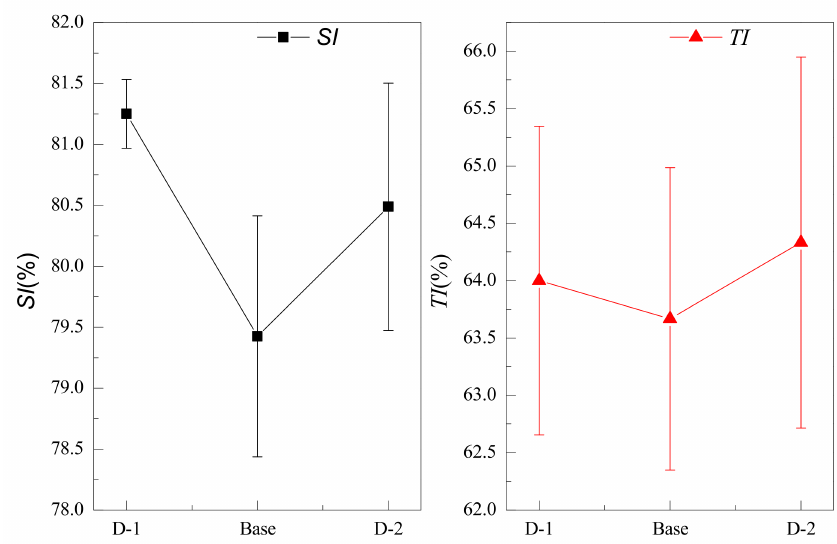
Figure 13. Influences of the fan negative pressure on sinter quality. (The negative pressure: D-1 = − 11 kPa; Base = − 12 kPa; D-2 = − 13 kPa).